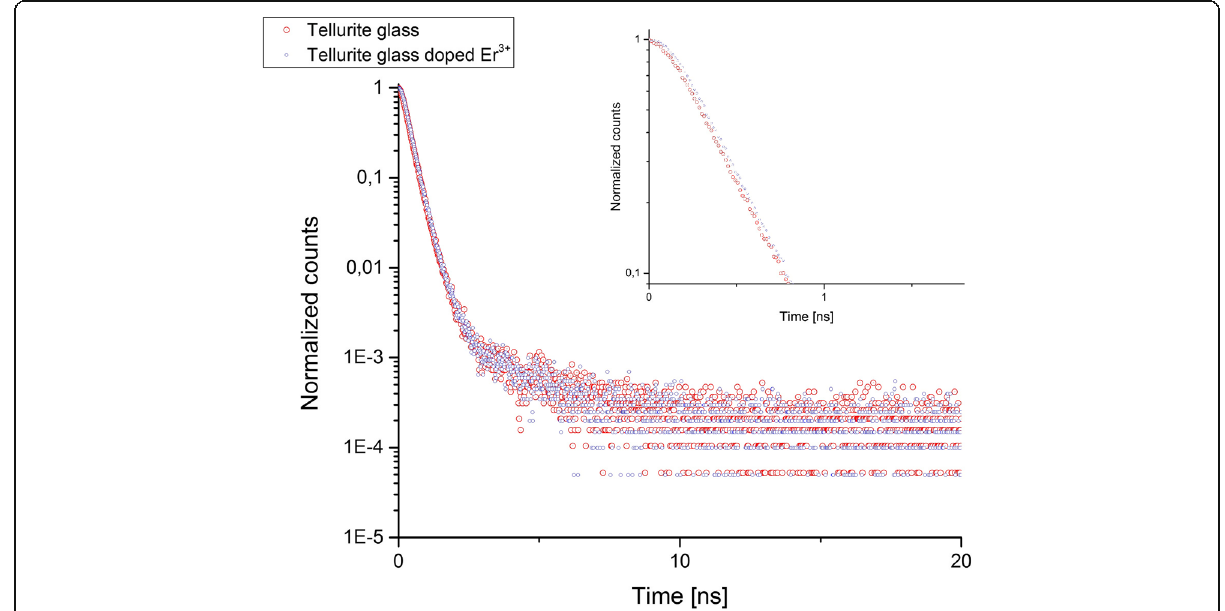
Fig. 1 The examples of experimental PALS spectra of tellurite glasses and tellurite glasses doped Er 3+ samples